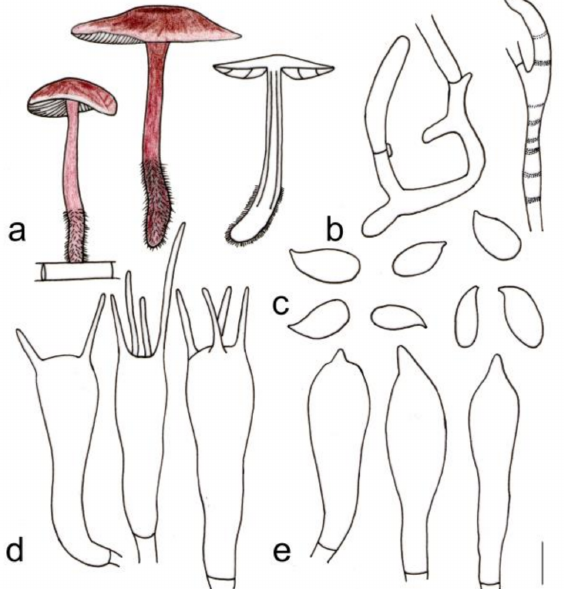
Figure 5. Morphological characteristics of Gymnopus longus (HMJAU 60291, holotype): ( a ) basid- iomata, ( b ) pileipellis, ( c ) basidiospores, ( d ) basidia, and ( e ) cheilocystidia. Scale bars: 1 cm ( a ), 25 µ m ( b ), and 5 µ m ( c – e